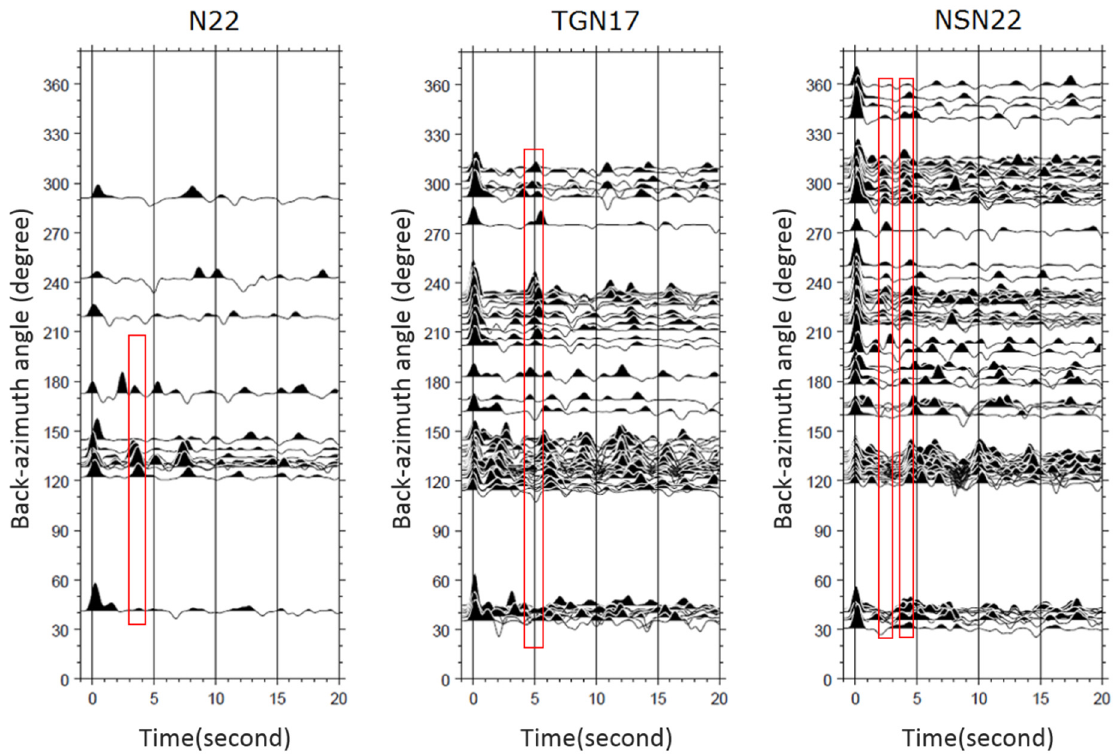
Figure 4. Back-azimuth receiver function plots of stations N22, TGN17 and